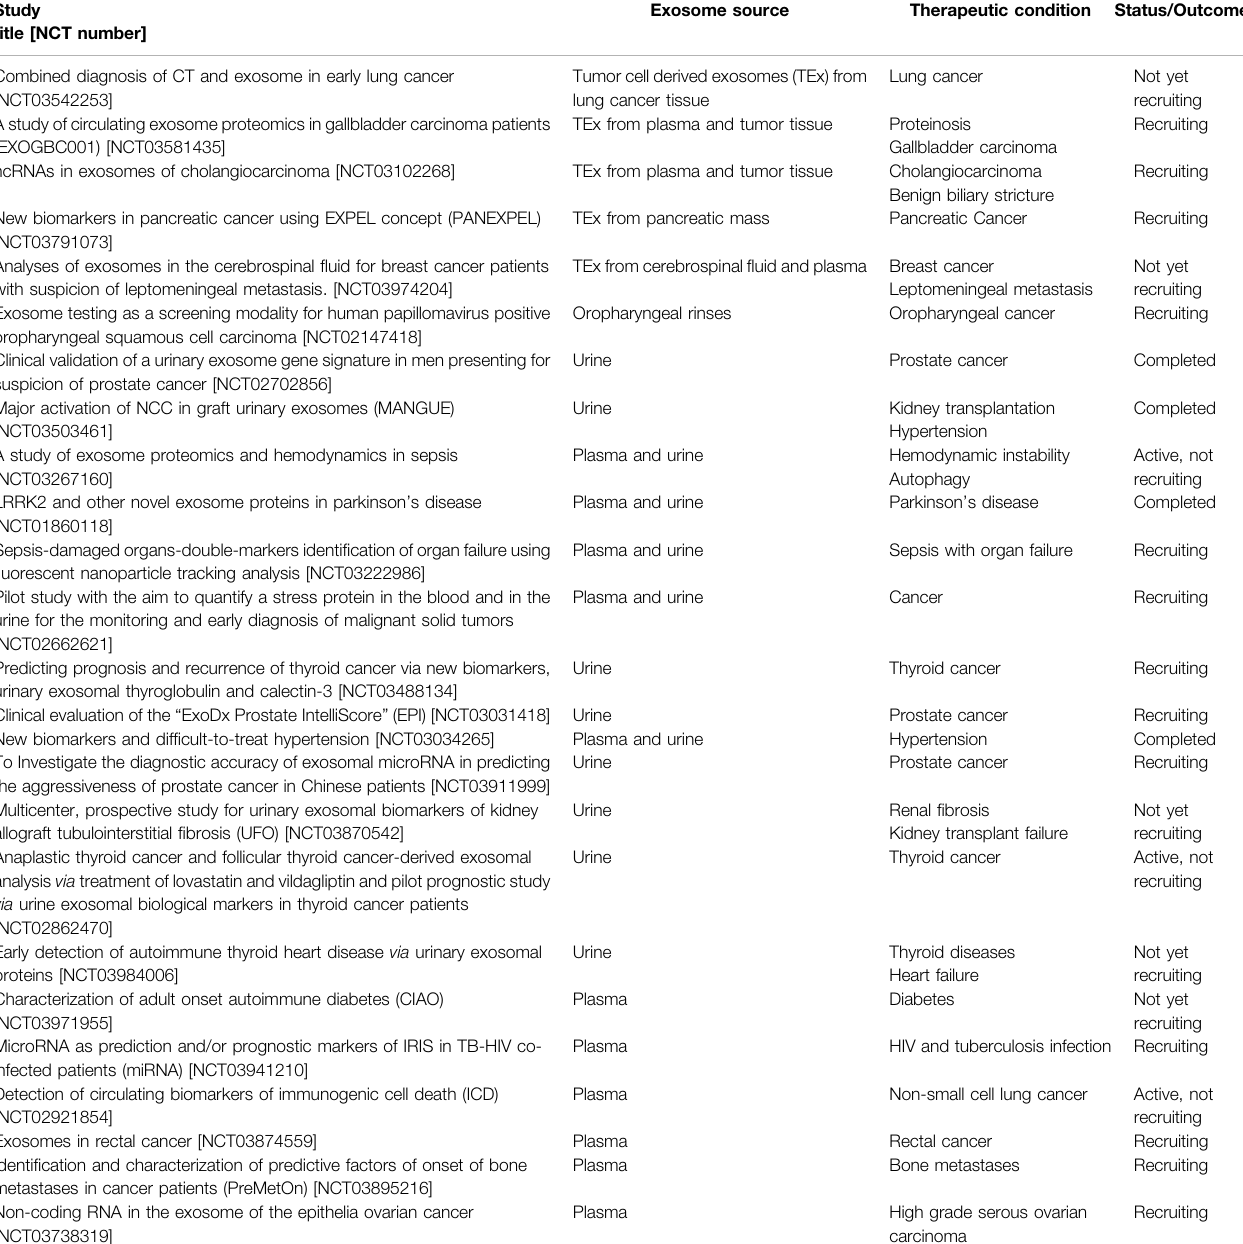
TABLE 4 | Clinical trials evaluating exosomes as a diagnostic biomarker (ClinicalTrials.gov,